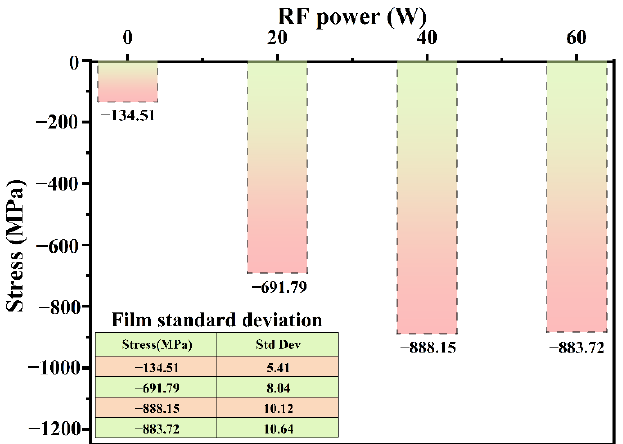
Figure 4. Film stress of the samples deposited under various RF bias powers.